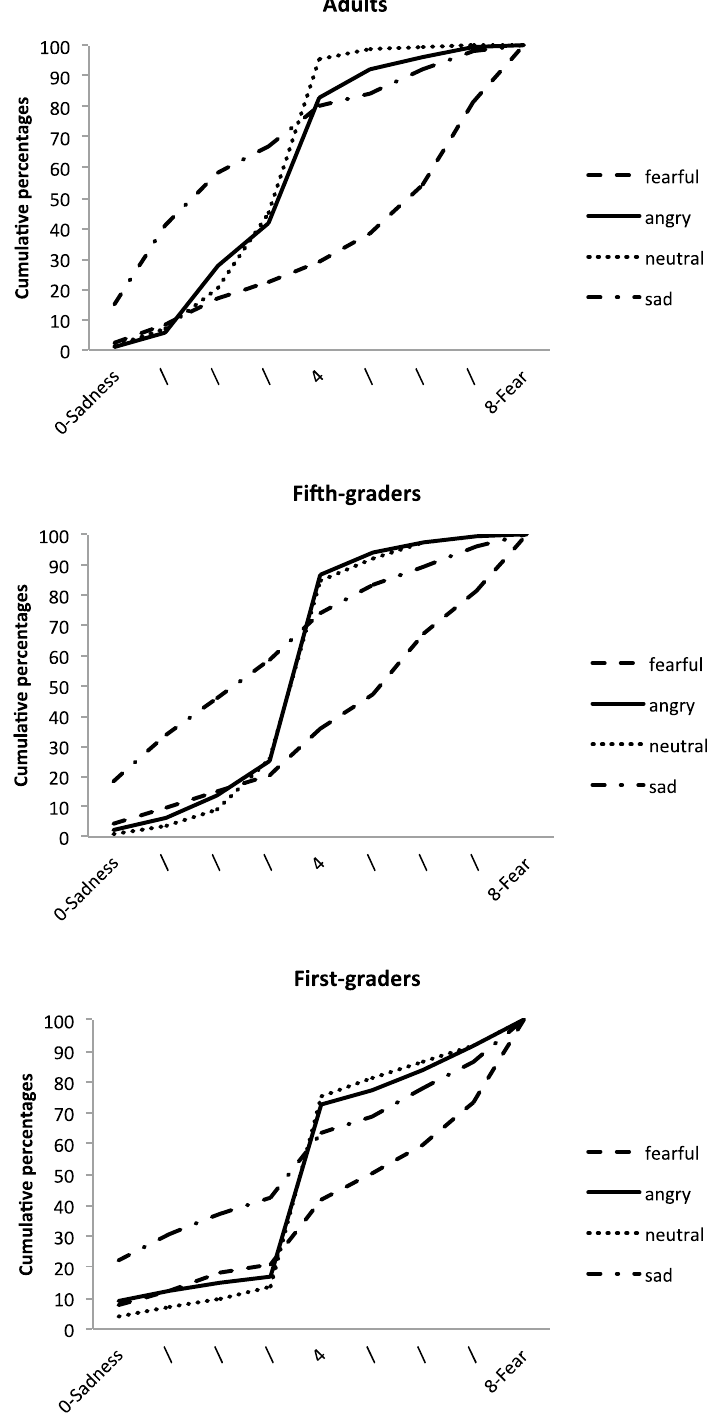
Figure 6. Cumulative percentages of the perception of EFE on Scale 3, for each age